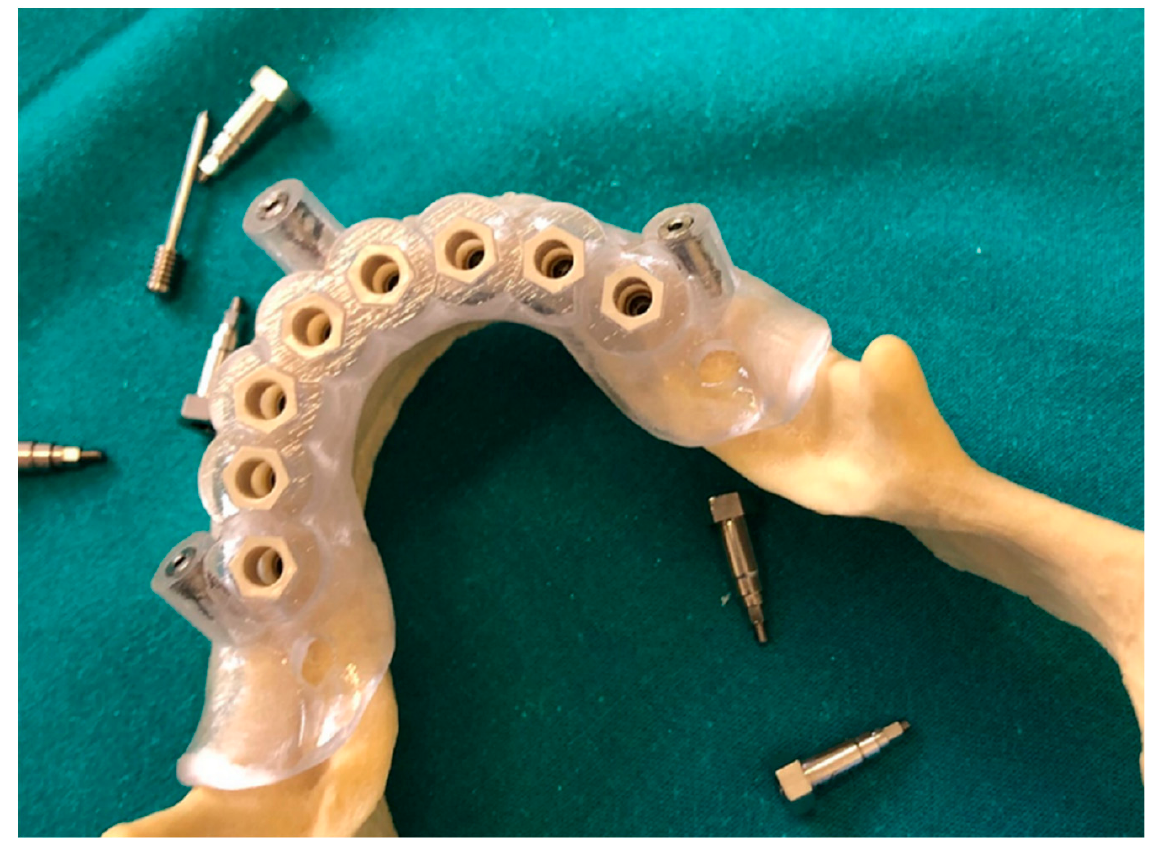
Figure 1. Surgical guide fixed to the acrylic resin model.